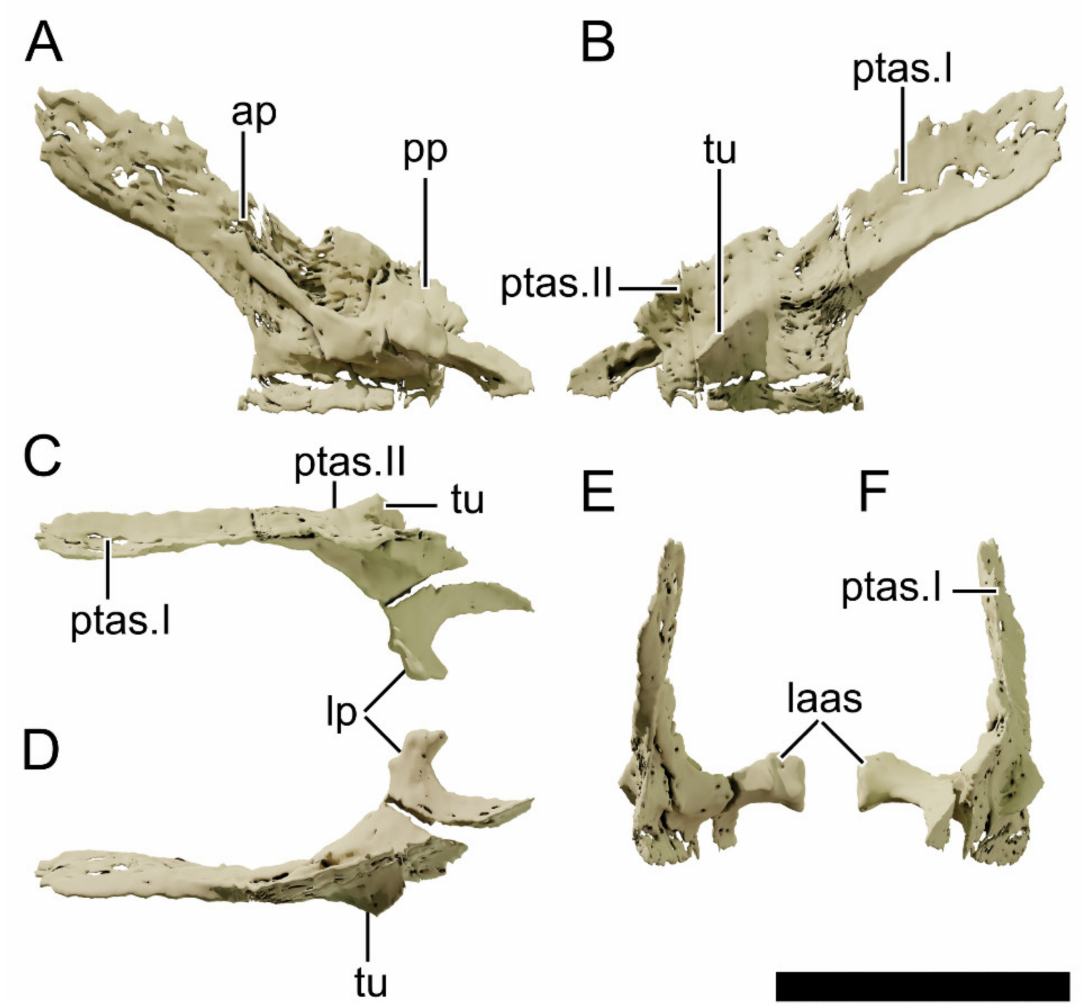
Figure 29. Digital reconstruction of the left palatine of NHMD 164758. ( A ) Lateral view. ( B ) Medial view. ( C ) Dorsal view. ( D ) Ventral view. ( E ) Anterior view. ( F ) Posterior view. Abbreviations: ap, anterior process; laas, articular surface for the lacrimal; lp, lateral process; pp, posterior process; ptas, articular surface for the pterygoid; tu,